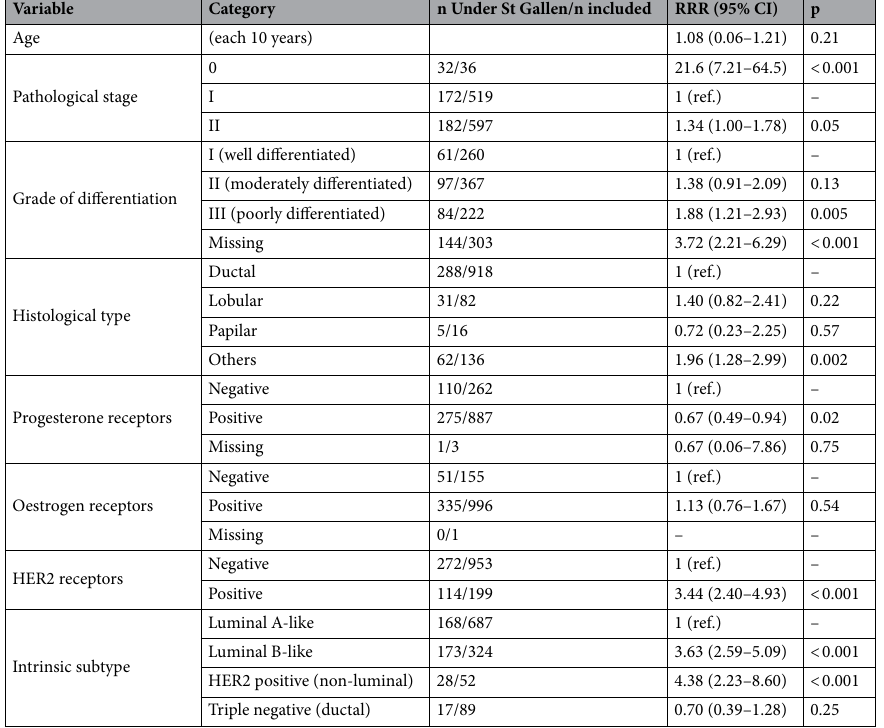
Table 4. Tumour characteristics associated with “Under St Gallen” treatment. Relative risk ratios (RRR) are adjusted for age at diagnosis and hospital of recruitment.